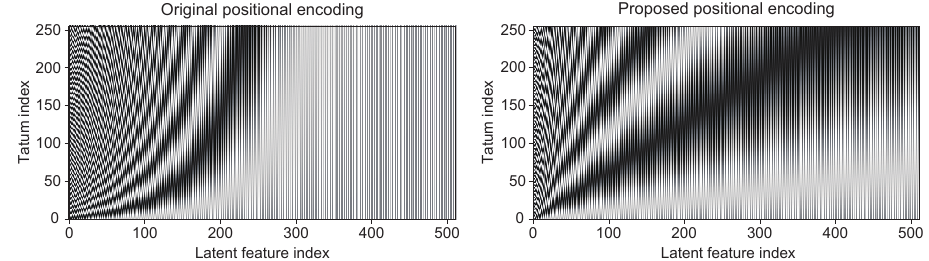
Figure 2. The original positional encoding described in [26] ( left ) and the proposed one ( right ) with D F = 512 and N =